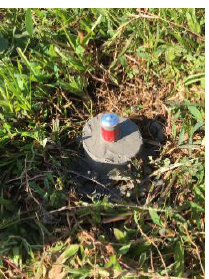
Figure 9. The example of observation stations established